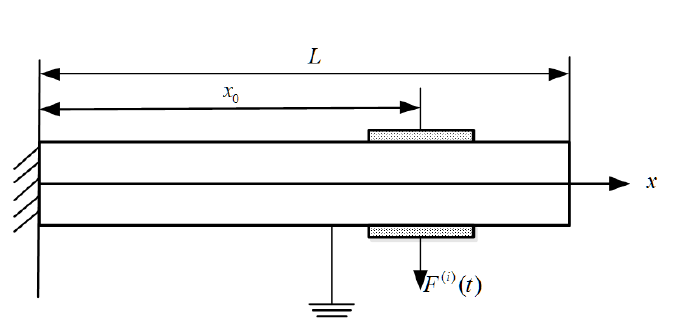
Figure 5. Excitation of a cantilever touching beam by a piezoelectric